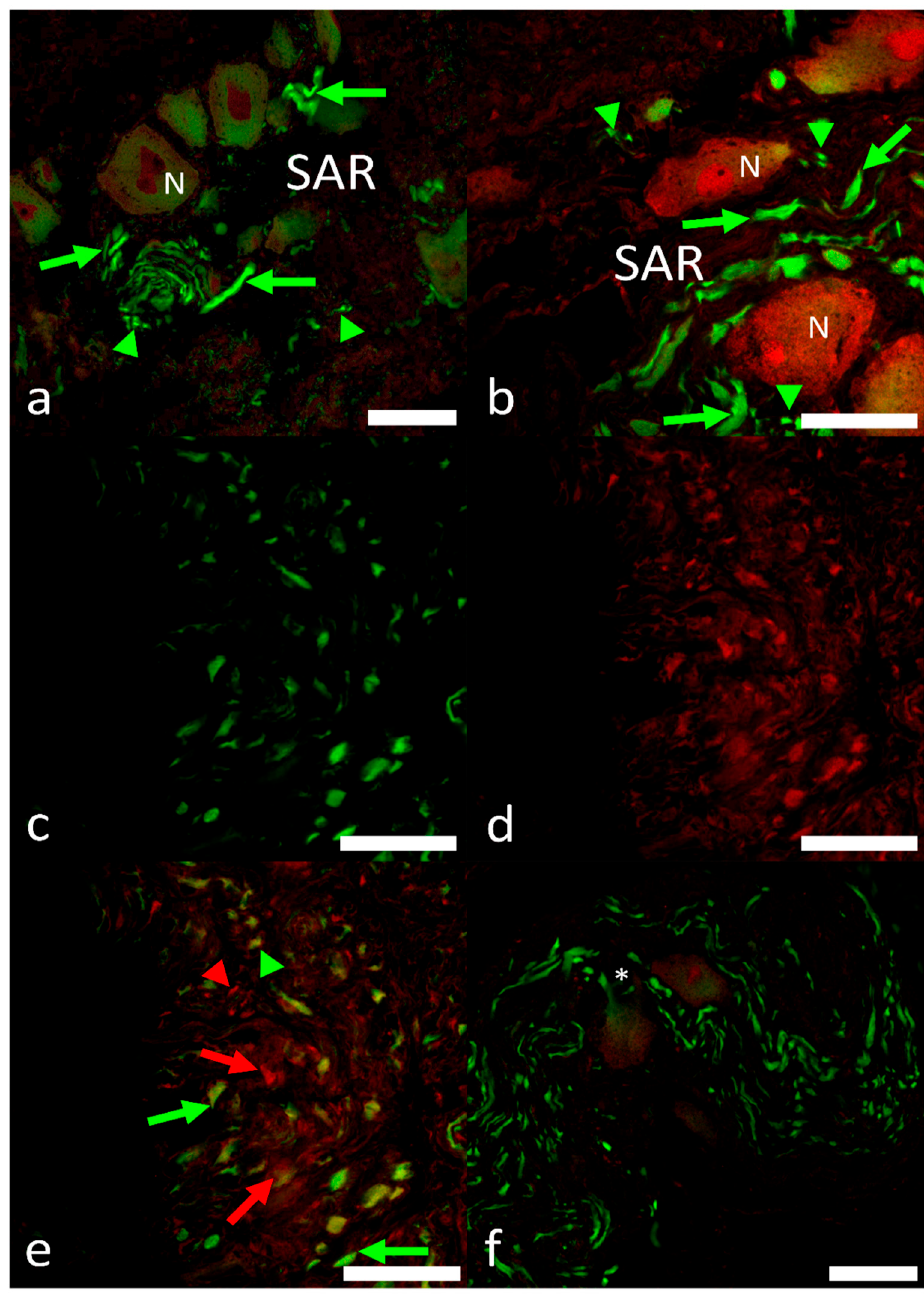
Figure 5. ( a , b ) Simultaneous detection of AcT and VAChT revealing abundant axon profiles (arrows) and nerve terminals (arrowheads) within the sinoatrial region (SAR). Cholinergic terminals (arrowheads) are identified among the neuronal somata (N). ( c – e ) A dense meshwork of both AcT and VAChT (c, d AcT and VAChT, respectively) axons and cholinergic terminals (e; merged) in the SAR is seen. ( f ) Neuronal somata in the AcT–immunoreactive axons neural meshwork located in the SAR. An asterisk indicates the axon from the hillock in a neuronal cell body. Scale bars: 20 µm. The simultaneous detection of HCN4 and Hu has been used to identify the pres- ence of the pacemaker cells among Hu-immunoreactive nerve fibers and axon bundles (Figure